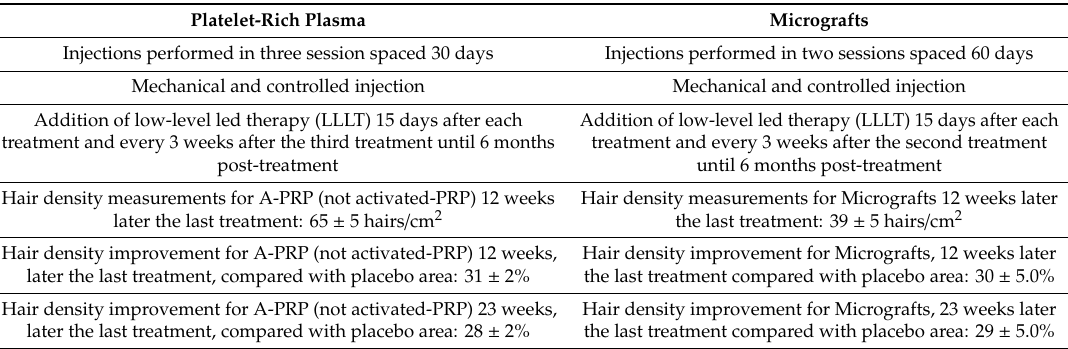
Table 1. Study design and clinical results obtained using Micrografts containing HFSCs and autologous platelet-rich plasma not activated (A-PRP).